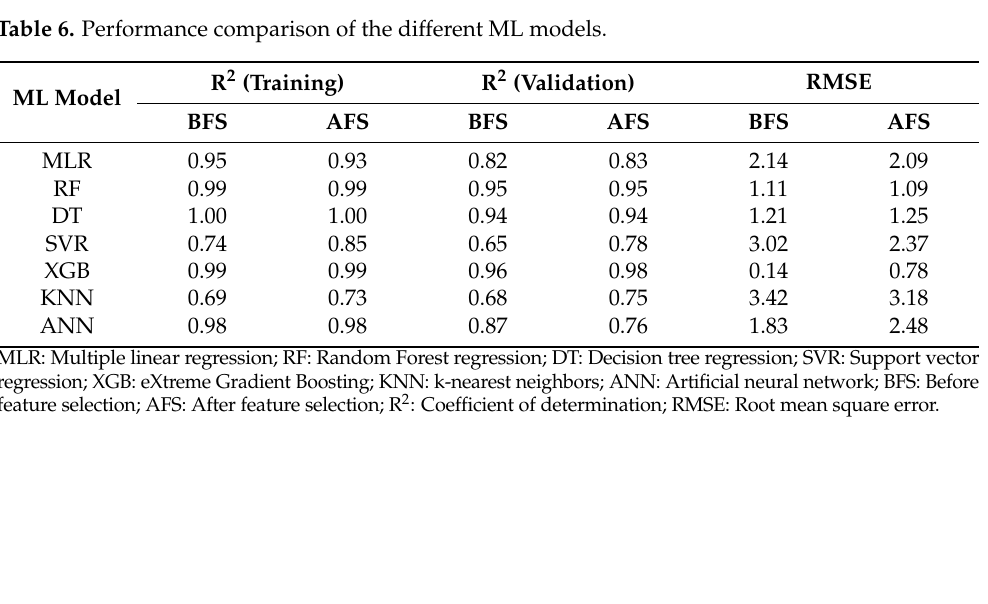
Table 6. Performance comparison of the different ML models.